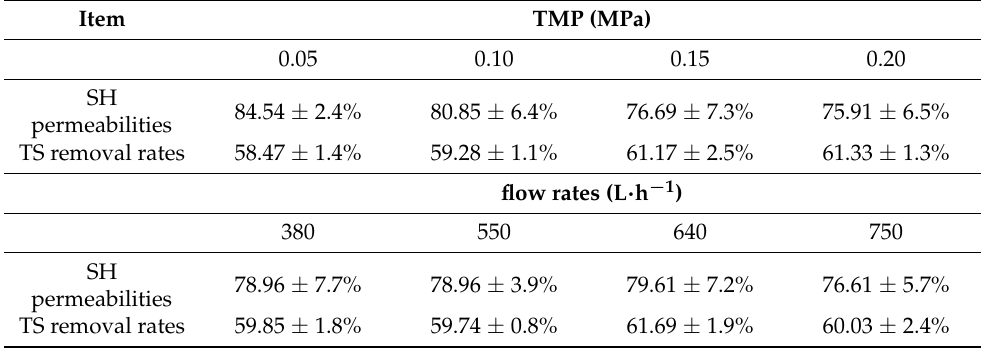
Table 4. SH permeabilities and TS removal rates under TMP and flow rates ( n = 3).